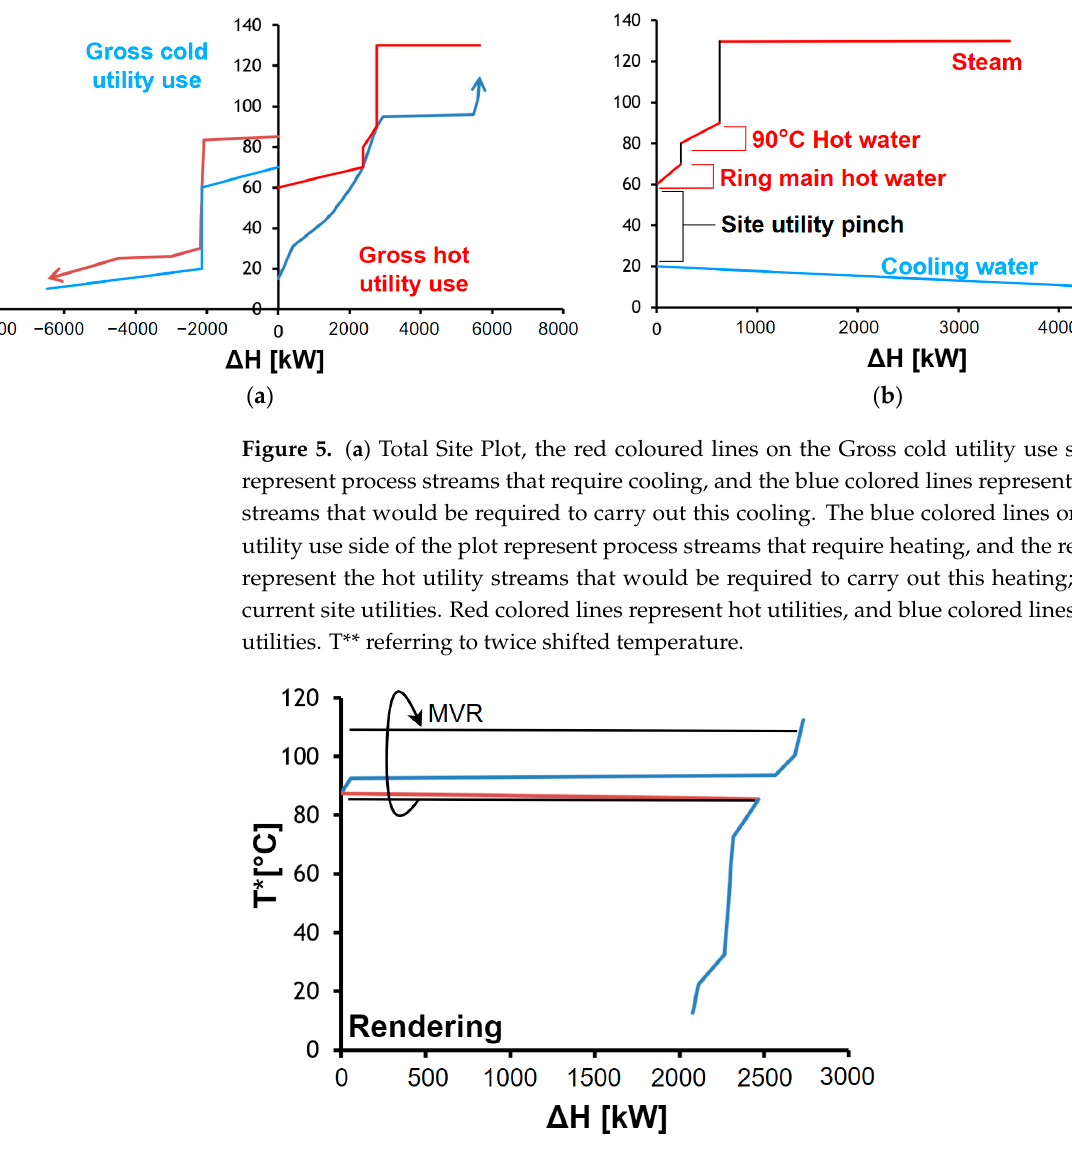
Figure 6. System Composite Curve of the Rendering processing zone with potential Mechanical Vapour Recompression (MVR) placement. Red lines represent streams that require cooling, and blue lines represent streams that need heating. T* referring to the shifted temperature.